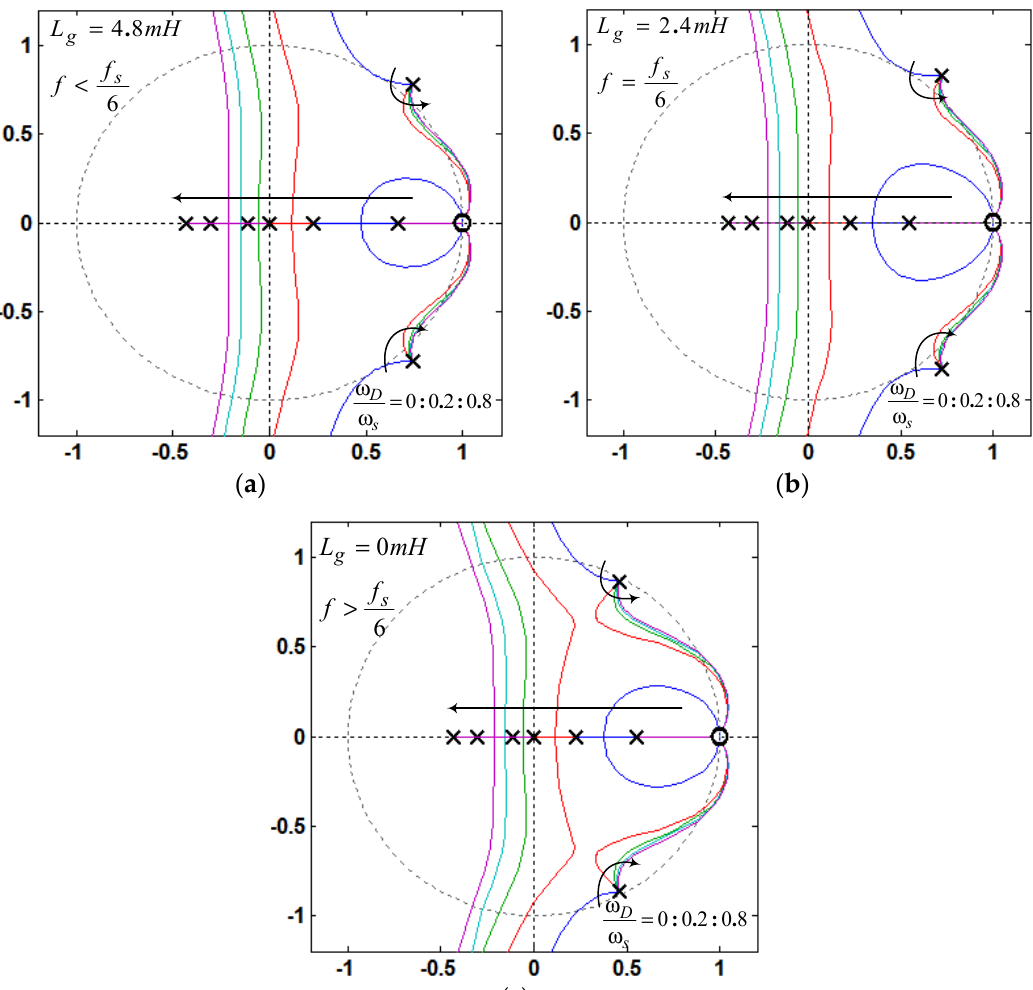
Figure 19. Root loci of the grid-side current control with and without CCF AD scheme for different grid inductances: ( a ) L g = 4.8 mH, f res = 1.521 kHz, K P = 0.09, K i = 25.8 (low resonant frequency region); ( b ) L g = 2.4 mH , f res = 1.667 kHz, K P = 0.09, K i = 25.8 (critical resonant frequency); and ( c ) L g = 0 mH, f res = 2.119 kHz, K P = 0.06, K i = 26.5 (high resonant frequency region).